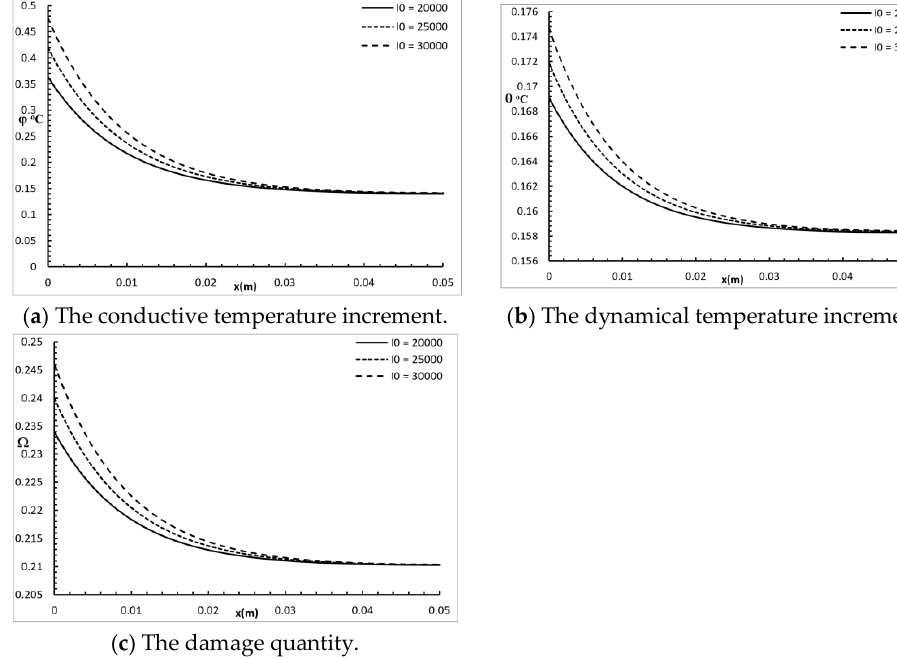
Figure 7. The studied functions for various values of the power density parameter.